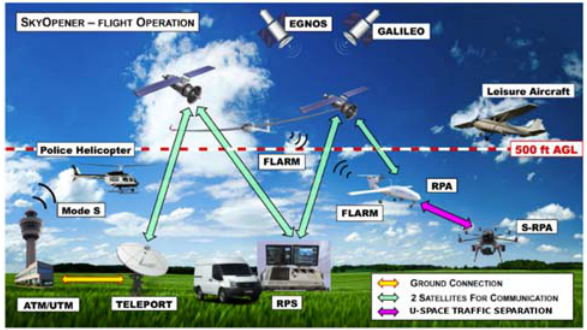
Figure 1. Skyopener system architecture.